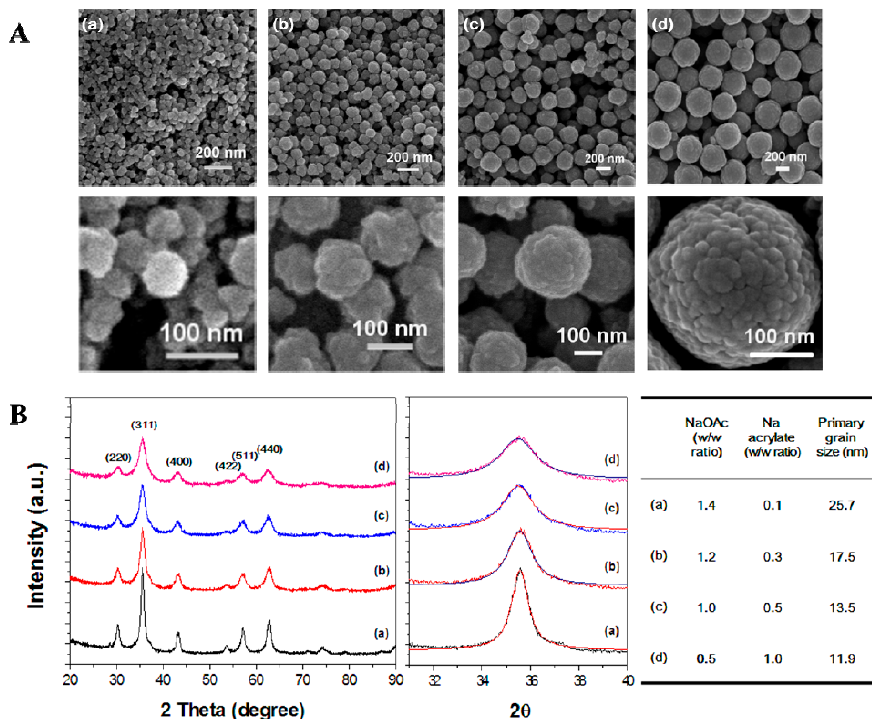
Figure 1. Morphology and crystal structure of CoFe 2 O 4 submicron particles with controlled external size: ( A ) FE-SEM images of CoFe 2 O 4 particles with controlled external size synthesized using different volume ratios of V EG /V DEG : (a) 5/15, (b) 10/10, (c) 15/5, and (d) 20/0. Other experimental parameters were kept constant (NaOAc = 1.0 g, Na acrylate = 0.5 g, temperature = 200 °C, and time = 10 h); ( B ) XRD patterns of CoFe 2 O 4 particles with tunable grain sizes obtained using different mass ratios of NaOAc/Na acrylate ( w / w ): (a) 1.4/0.1, (b) 1.2/0.3, (c) 1.0/0.5, and (d) 0.5/1.0. Other experimental parameters were kept constant (EG = 15 mL, DEG = 5 mL, temperature = 200 °C, and time = 10 h).